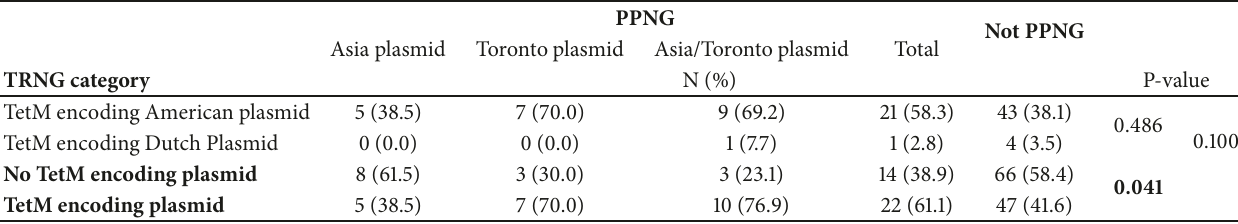
Table 4: Distribution of the beta-lactamase-encoding and TetM-encoding plasmids among 149 NG samples